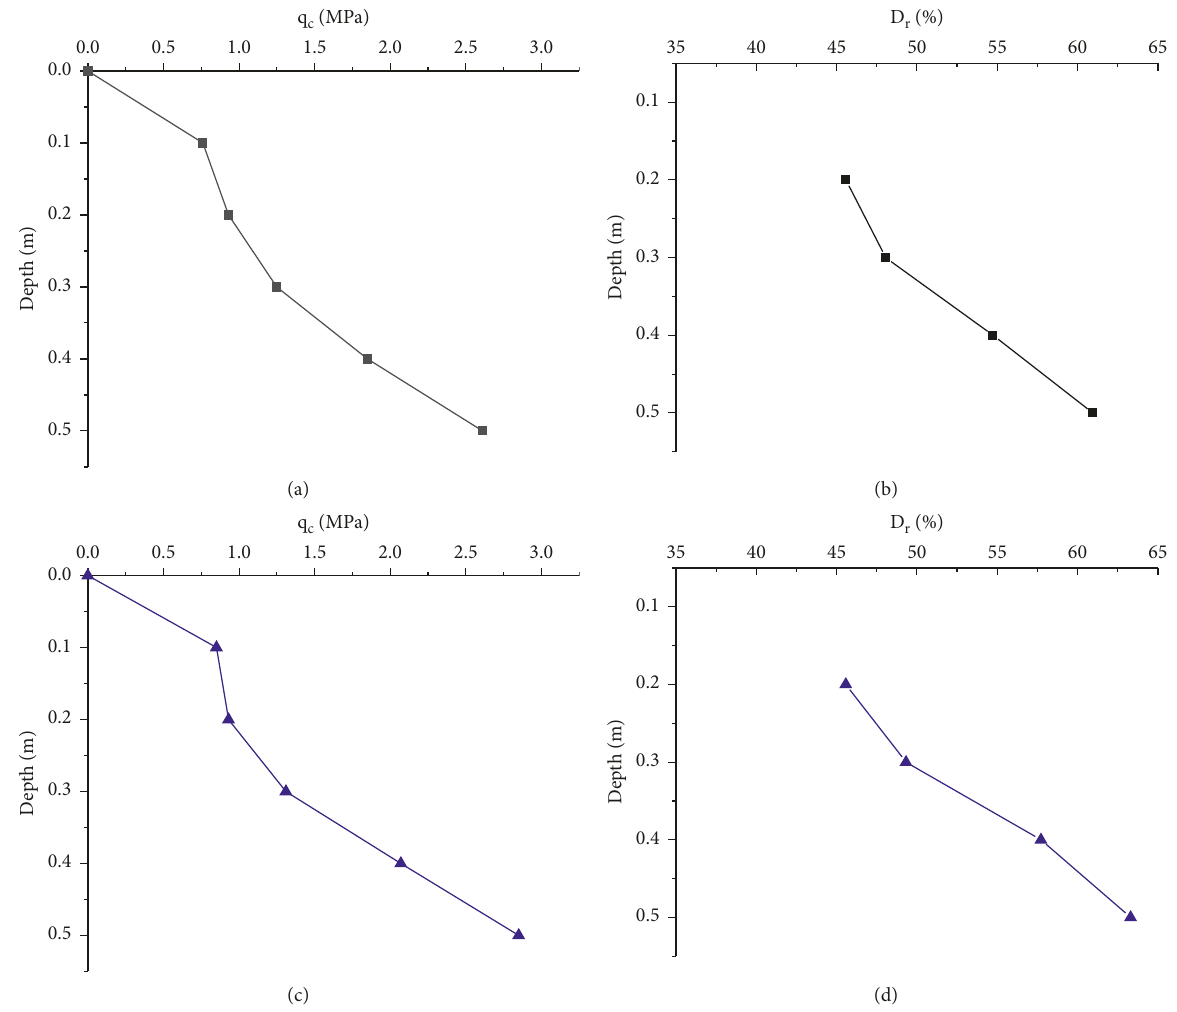
Figure 11: Condition of the site after the tests. (a) Cone tip resistance curve of the site after the simultaneous fracturing test, (b) relative density of the site after the simultaneous fracturing test, (c) cone tip resistance curve of the site after the multiple fracturing tests, and (d) relative density of the site after the multiple fracturing